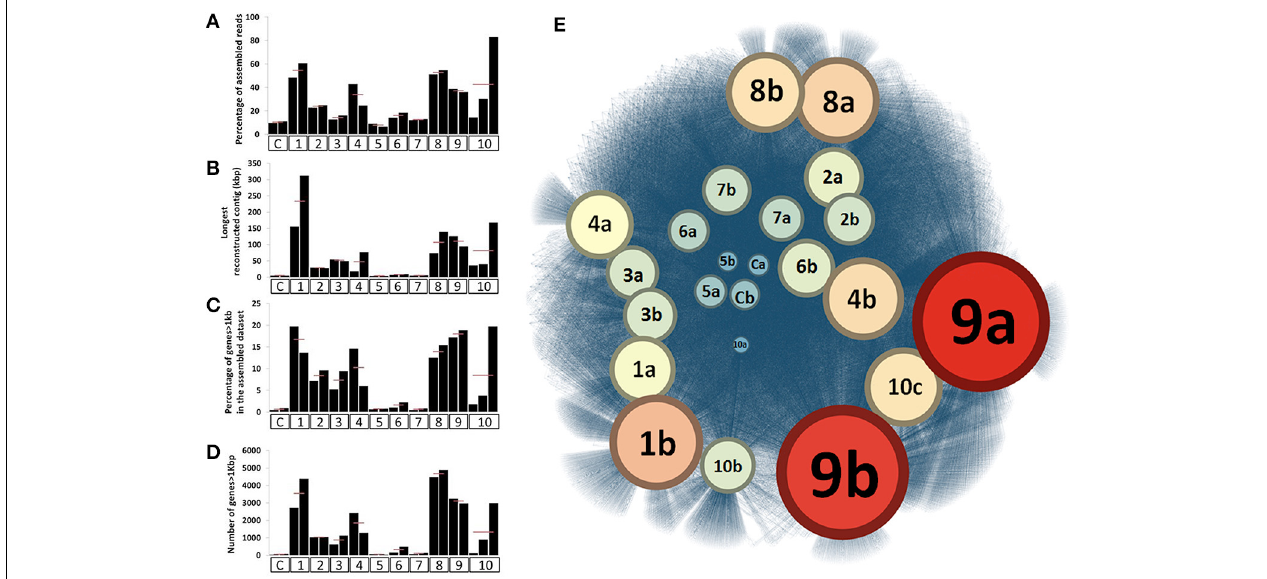
FIGURE 2 | Panels (A,B) represent the relative percentage of assembled reads and longest reconstructed contig after assembling the 23 datasets, respectively. Panels (C,D) represent the number and percentage of genes longer than 1kb recovered from these assemblies, respectively. For (A–D) , X-axes identify different ESCs. Finally, (E) represents a functional network linking the 23 assembled metagenomic datasets and the 24,291 distinct functions annotated from